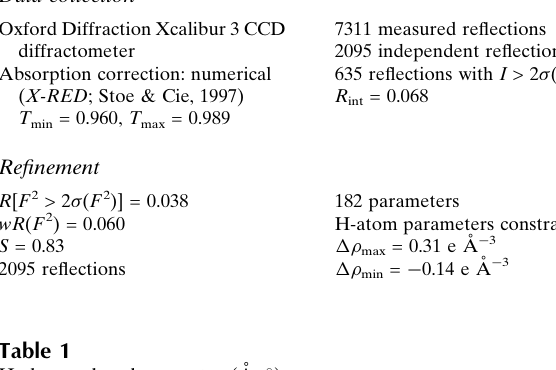
Hydrogen-bond geometry (A˚ , (cid:3)